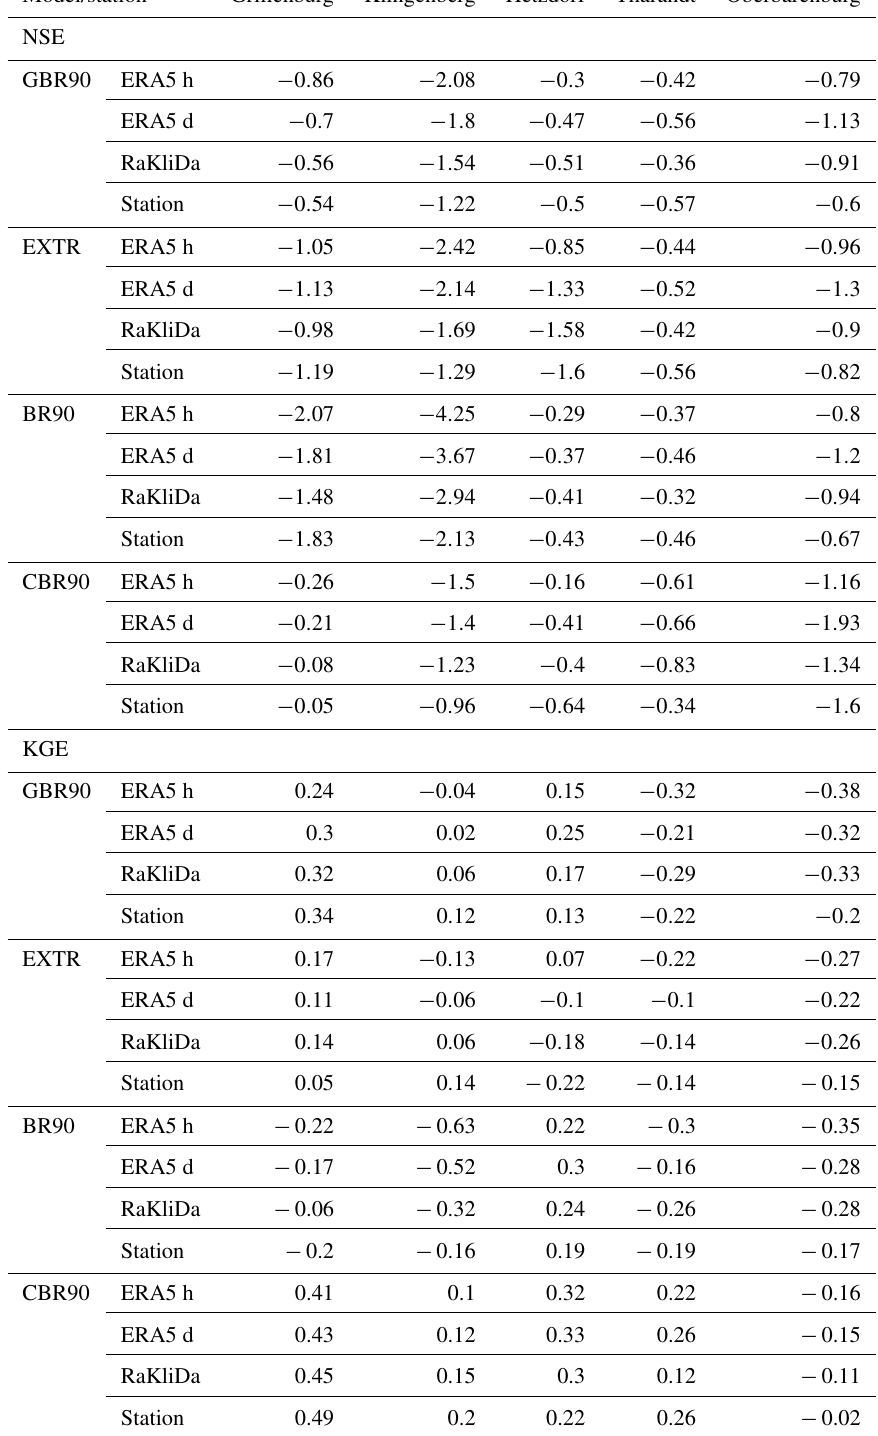
Table E3. Daily evaporation skill scores for the winter period.